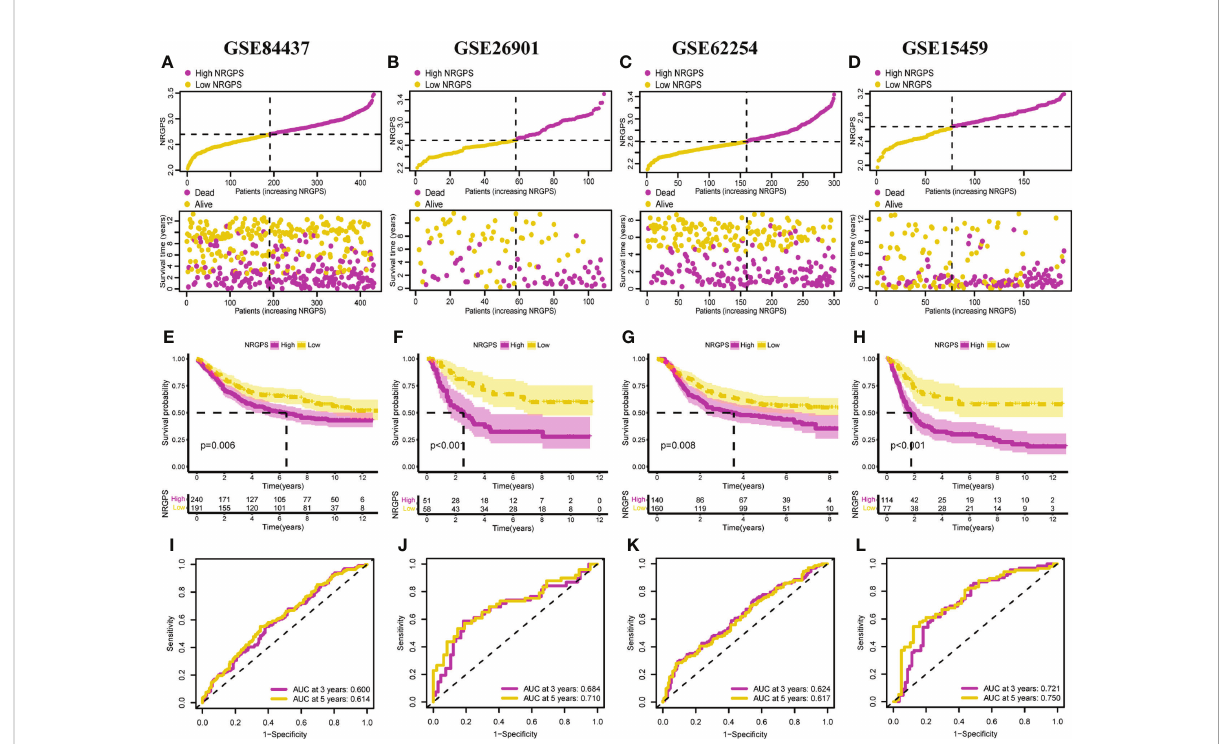
FIGURE 5 Validation of the NRGPS System. Distribution of NRGPS and survival status in the high-NRGPS and low-NRGPS groups in (A) GSE84437, (B) GSE62901, (C) GSE62254, (D) GSE15459. Kaplan-Meier survival analysis in (E) GSE84437, (F) GSE62901, (G) GSE62254, (H) GSE15459. The ROC analysis in (I) GSE84437, (J) GSE62901, (K) GSE62254, and (L) GSE15459 veri fi es the prediction ability of this prediction model. NRGPS, necroptosis-related gene prognostic score; GC, Gastric cancer; ROC, receiver operating